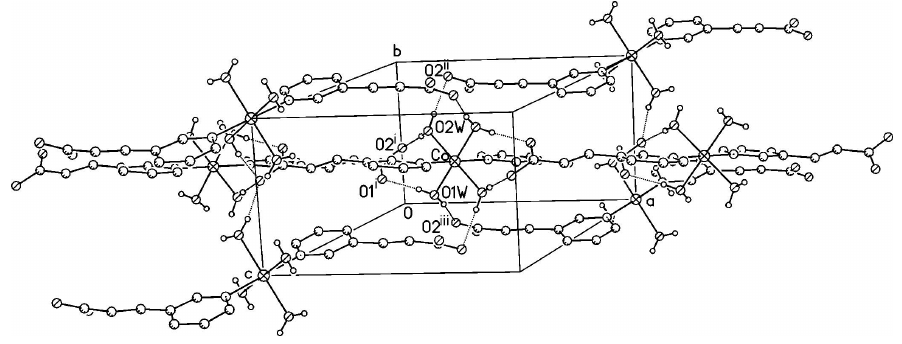
Figure 2 A packing diagram of (I). Hydrogen bonds are shown as dashed lines [symmetry codes: (i) - x , - y + 1, - z + 1; (ii) x + 1/2, - y + 3/2, z - 1/2; (iii) x + 1/2, - y + 1/2, z -